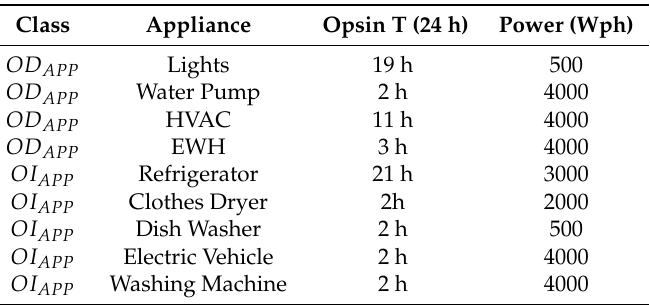
Table 3. Baseline